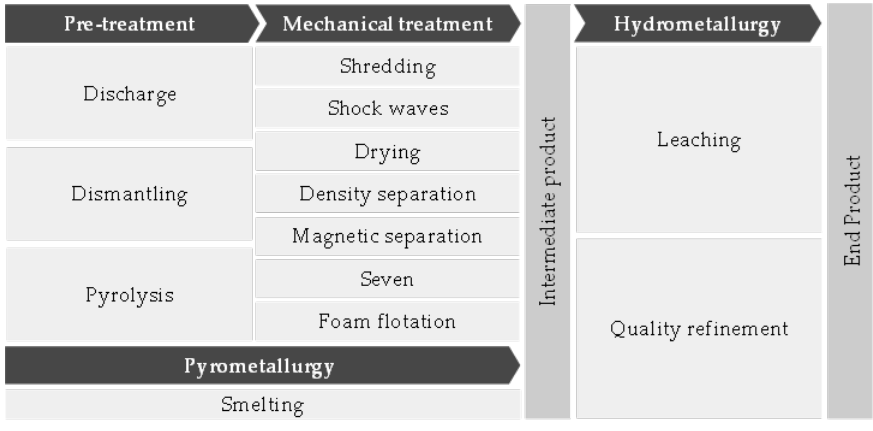
Figure 4. Visualization of recycling technologies.